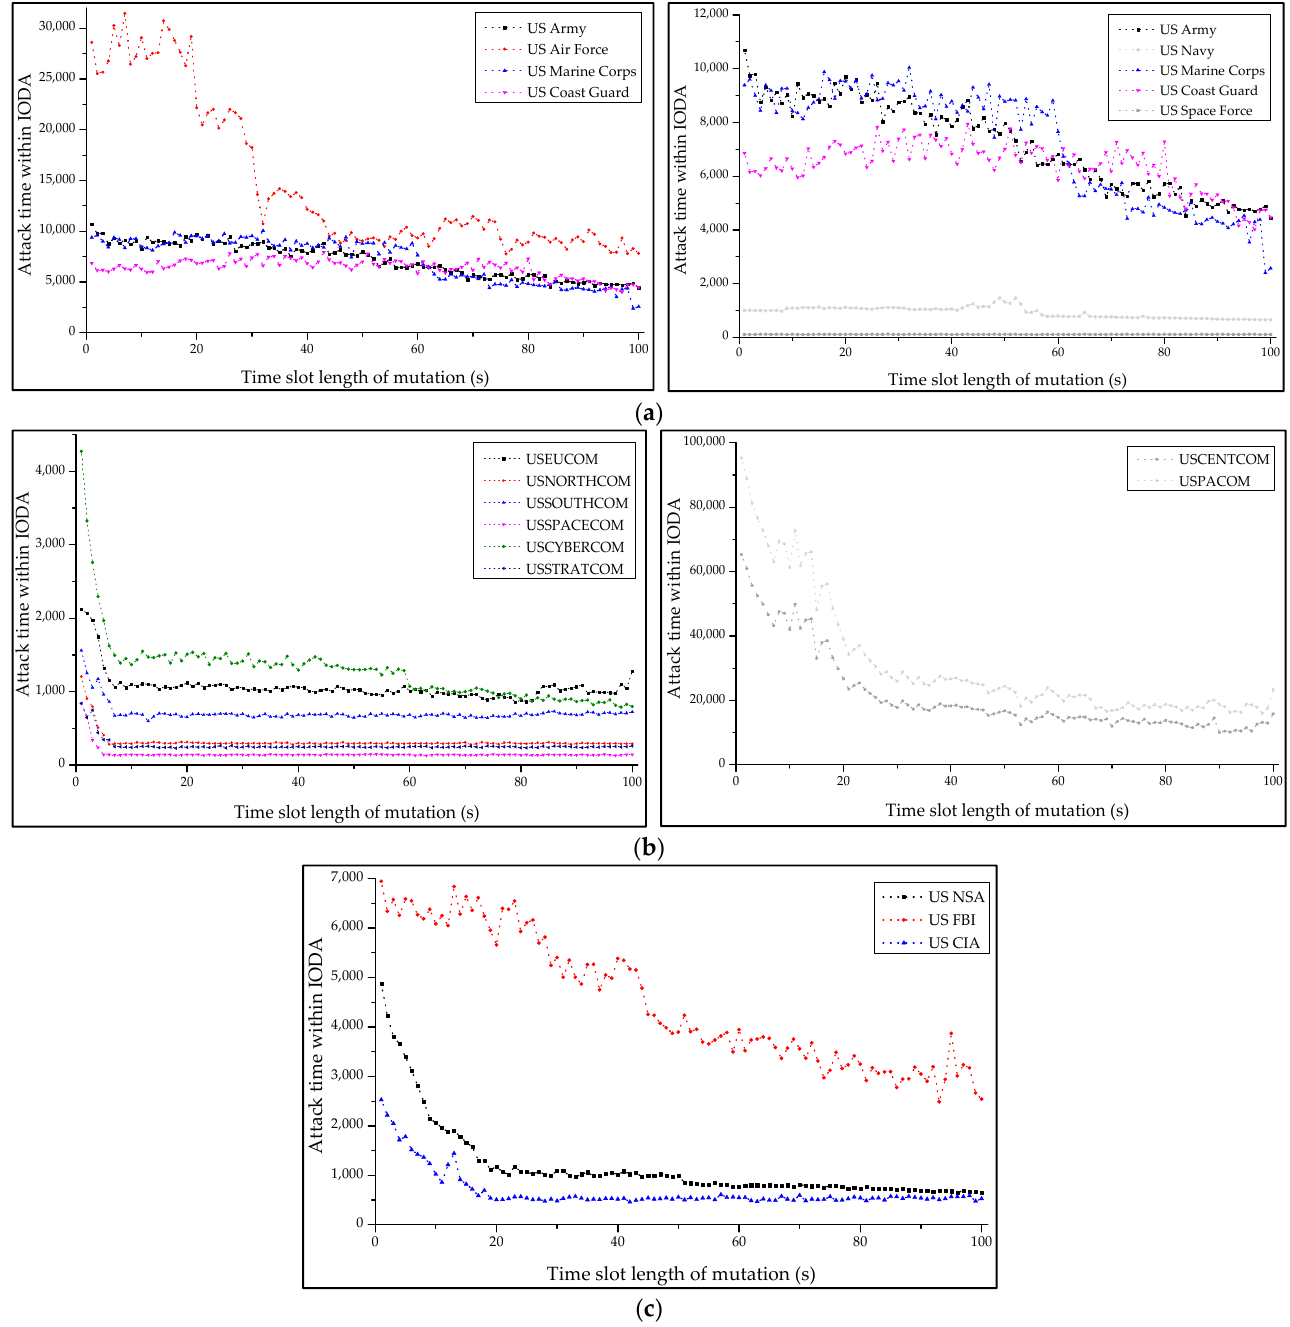
Figure 9. Comparative results of public OSINT-based environments by US organizations. ( a ) US Armed Forces-based, ( b ) US Unified Combatant Command-based, and ( c ) US Intelligence Community-based.